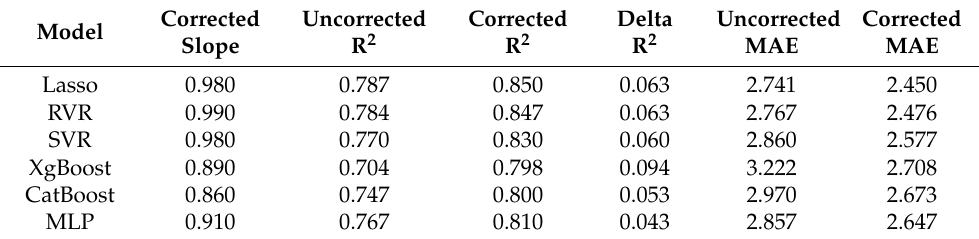
Table 6. Corrected slope vs. R 2